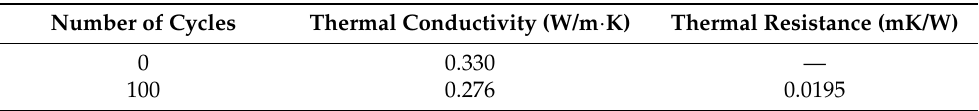
Table 17. Thermal conductivity results of insulating refractory concrete cylindrical samples after 100 thermal